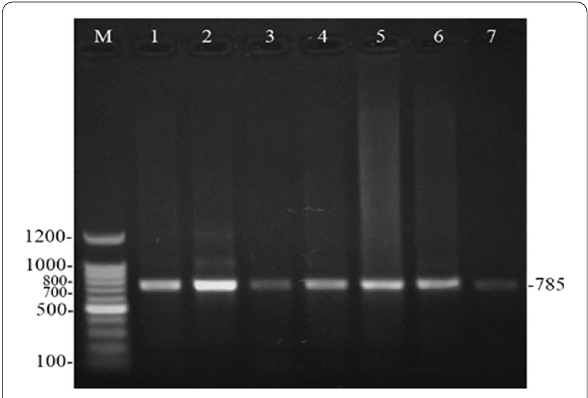
Fig. 4 PCR amplification product of TAMS 1 gene. Lane M: 100-bp DNA ladder (Imperial Life Sciences, NEB, USA). Lanes 1–7: Field